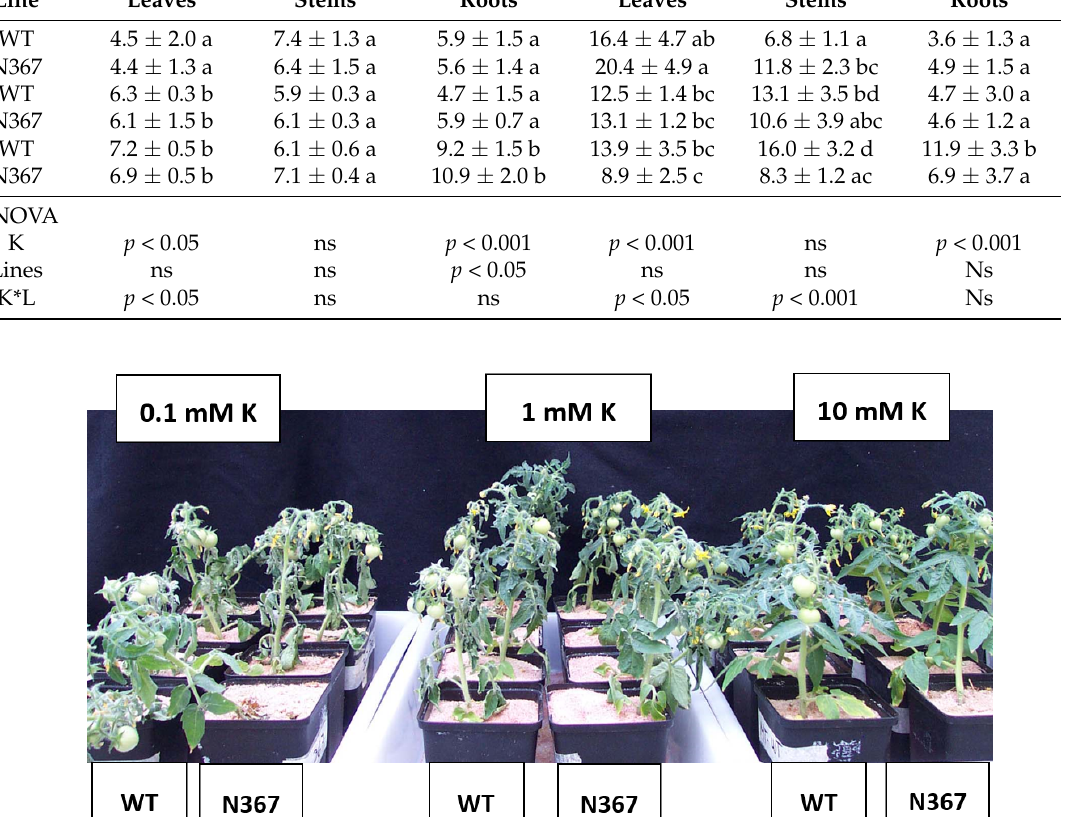
Table 6. Water and sugar contents in leaves, stems and roots of tomato WT and N367 lines at harvest when grown with different K concentrations and subjected to six cyclical drought periods. Means followed by the same letter are not significantly different (LSD Test, p < 0.05). K and L in ANOVA represent potassium and line factors, respectively. K Supply (mM)